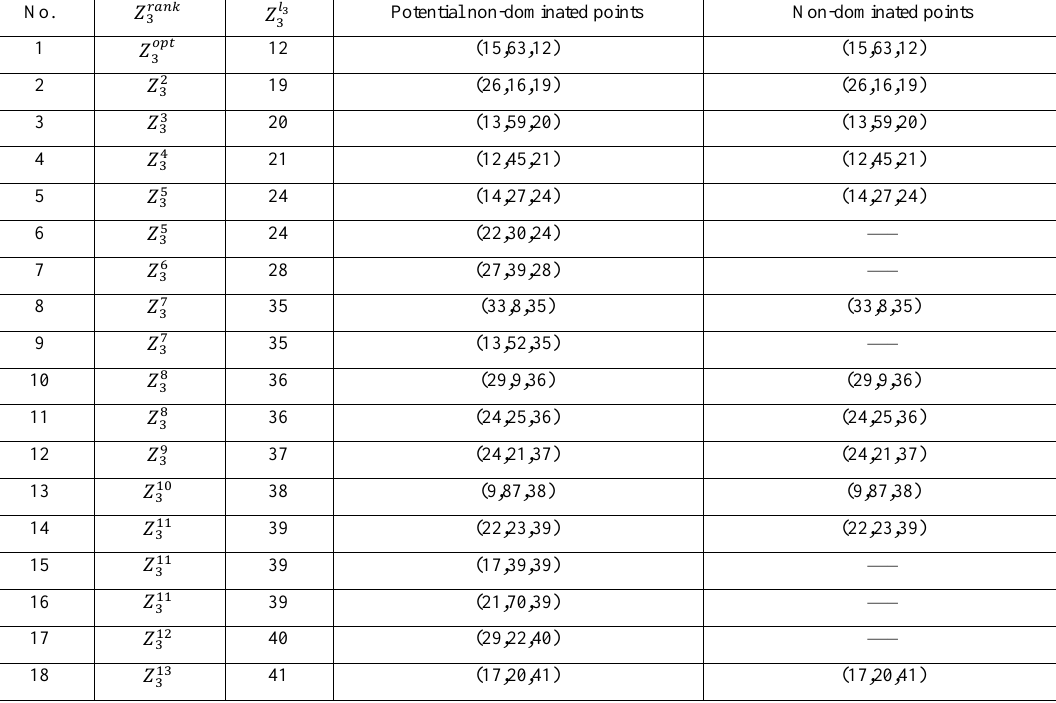
Table 10. Potential non-dominated points for third objective